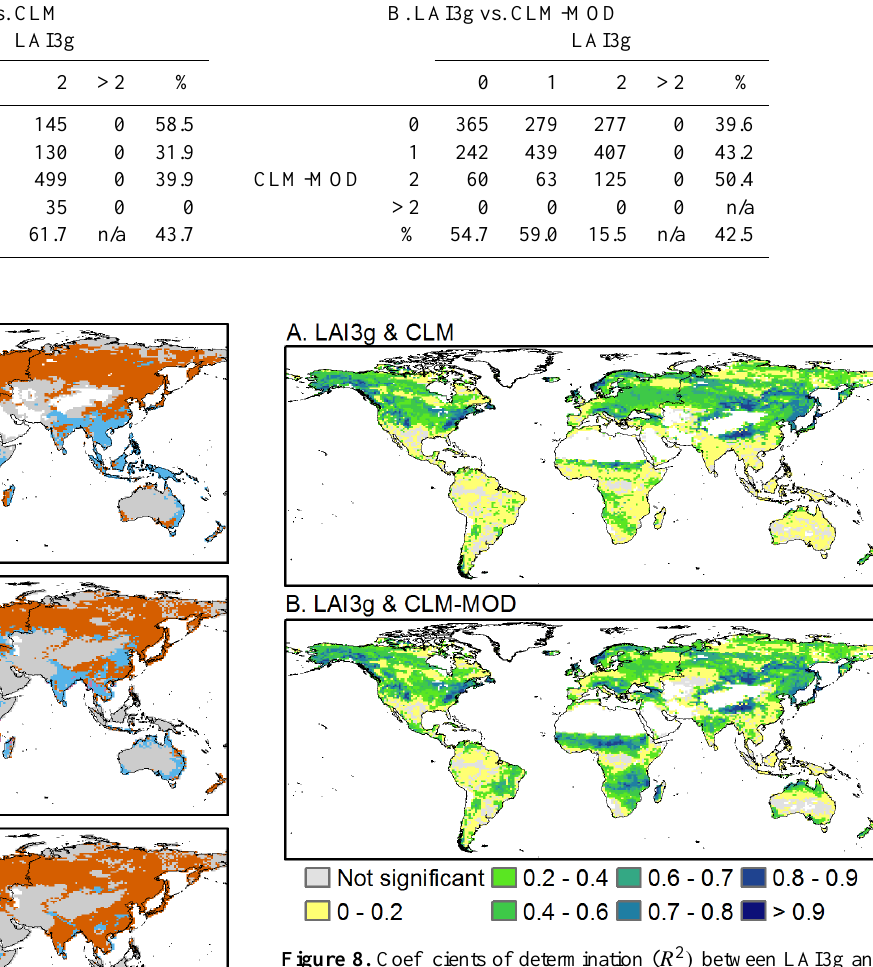
Figure 8. Coefficients of determination ( R 2 ) between LAI3g and the two model